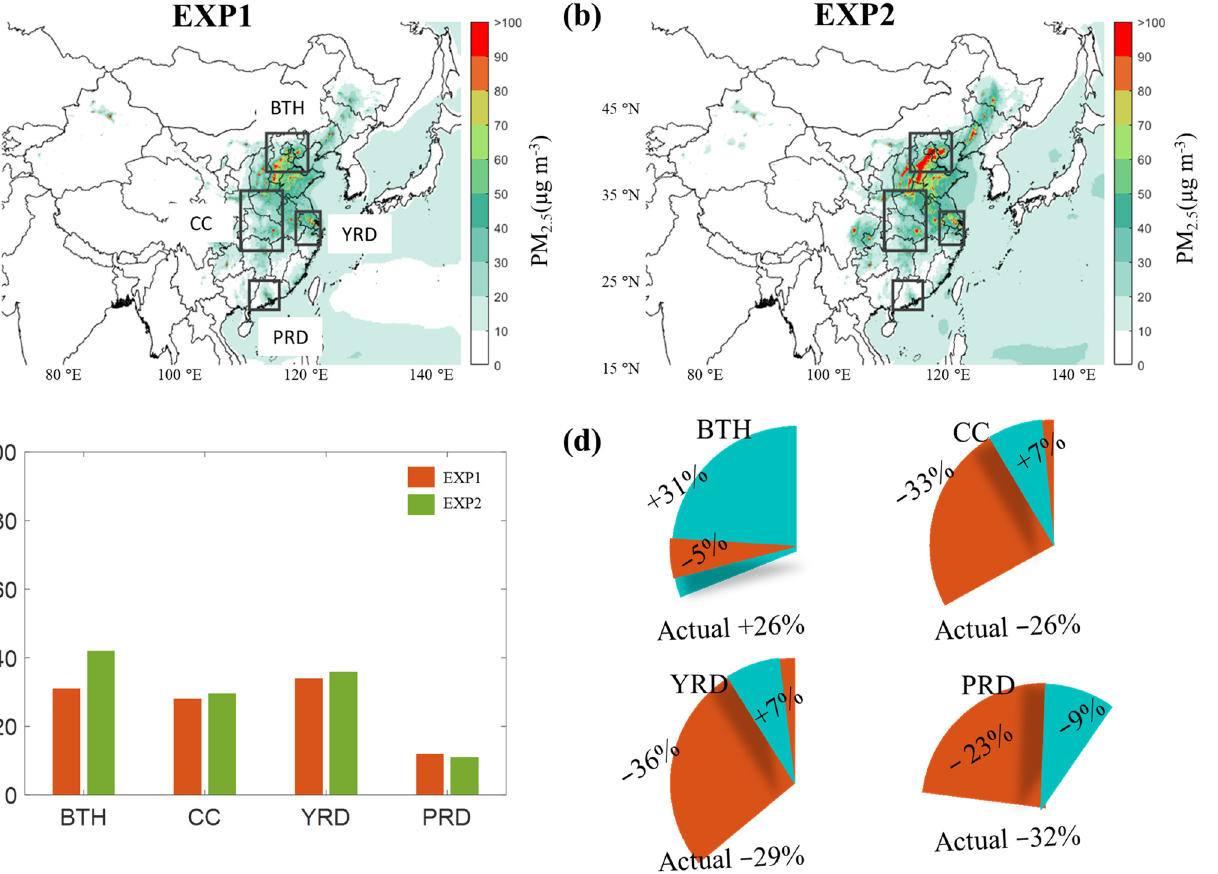
Figure 9. Simulated monthly average PM 2.5 mass concentration (µg m − 3 ) in China. ( a ) EXP1; ( b ) EXP2; ( c ) comparisons of PM 2.5 mass concentration between EXP1 and EXP2; ( d ) the relative contributions of changed emission and meteorological conditions to PM 2.5 mass concentration. The green parts and red parts in ( d ) represent meteorological conditions and emissions.